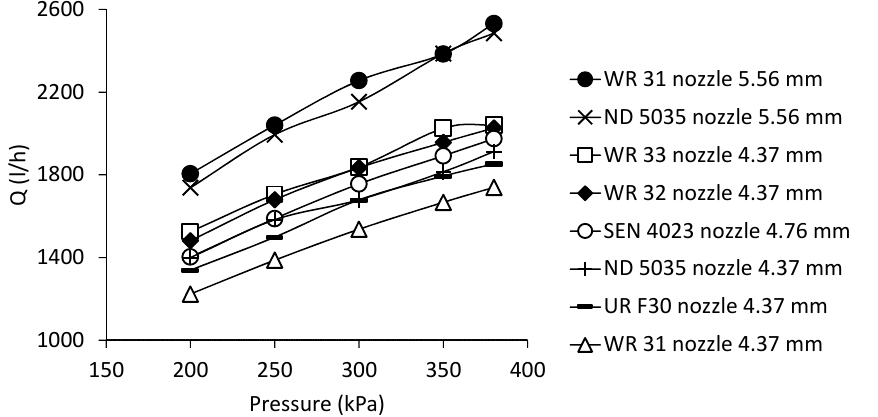
Figure 3. Sprinkler flow measurements.